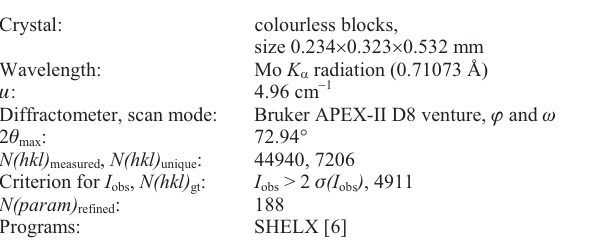
Table 1. Data collection and handling.